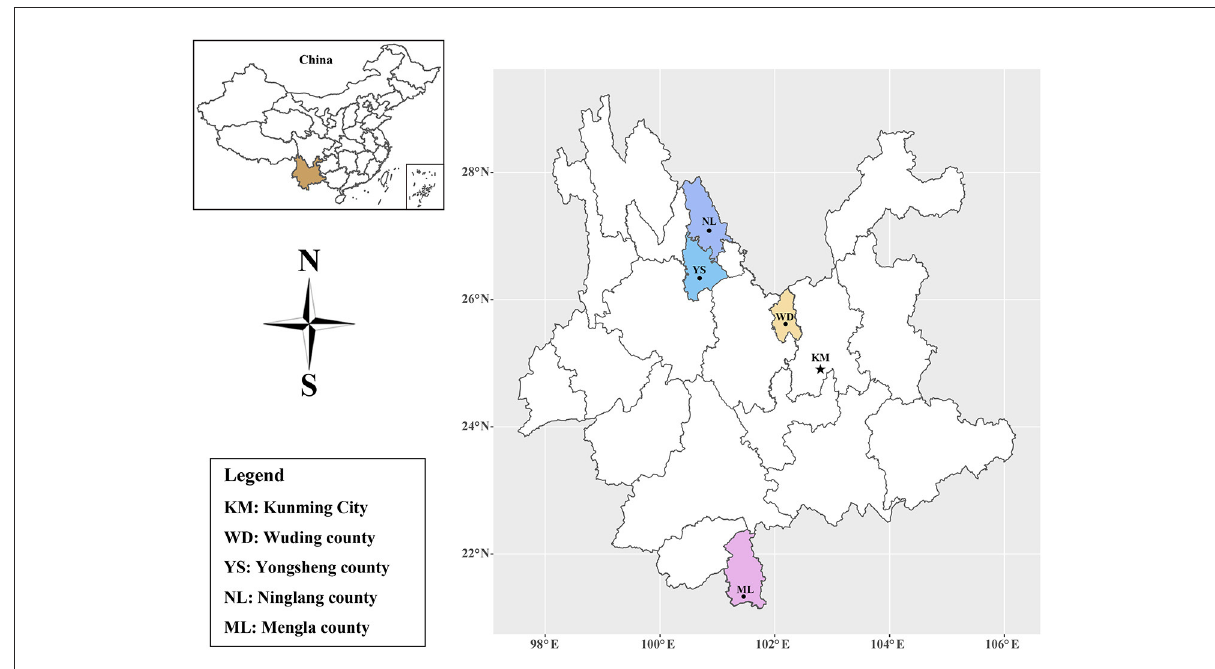
FIGURE1 Distribution map of the sampling sites in Yunnan Province, Southwestern